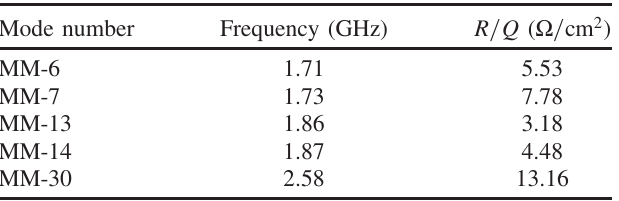
TABLE II. Summary of the expected TESLA nine-cell cavity dipolar modes ’ frequencies and R=Q values